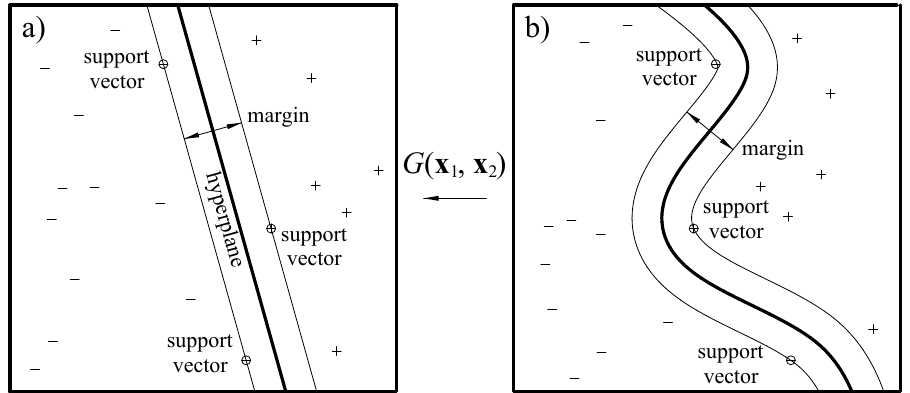
Figure 4. Sketch of a binary Support Vector Machine (SVM) highlighting the behaviour of the kernel function mapping the space ( b ) to the ( a )